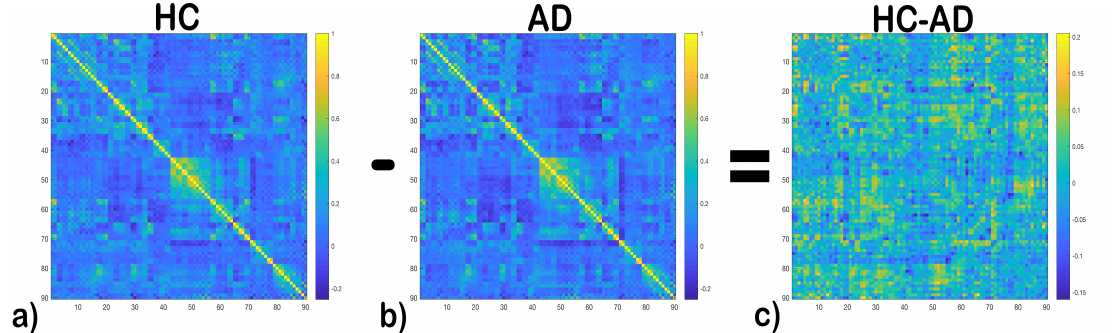
Figure 3. Connectivity matrices for the ( a ) AD group, ( b ) HC group, and ( c ) the difference